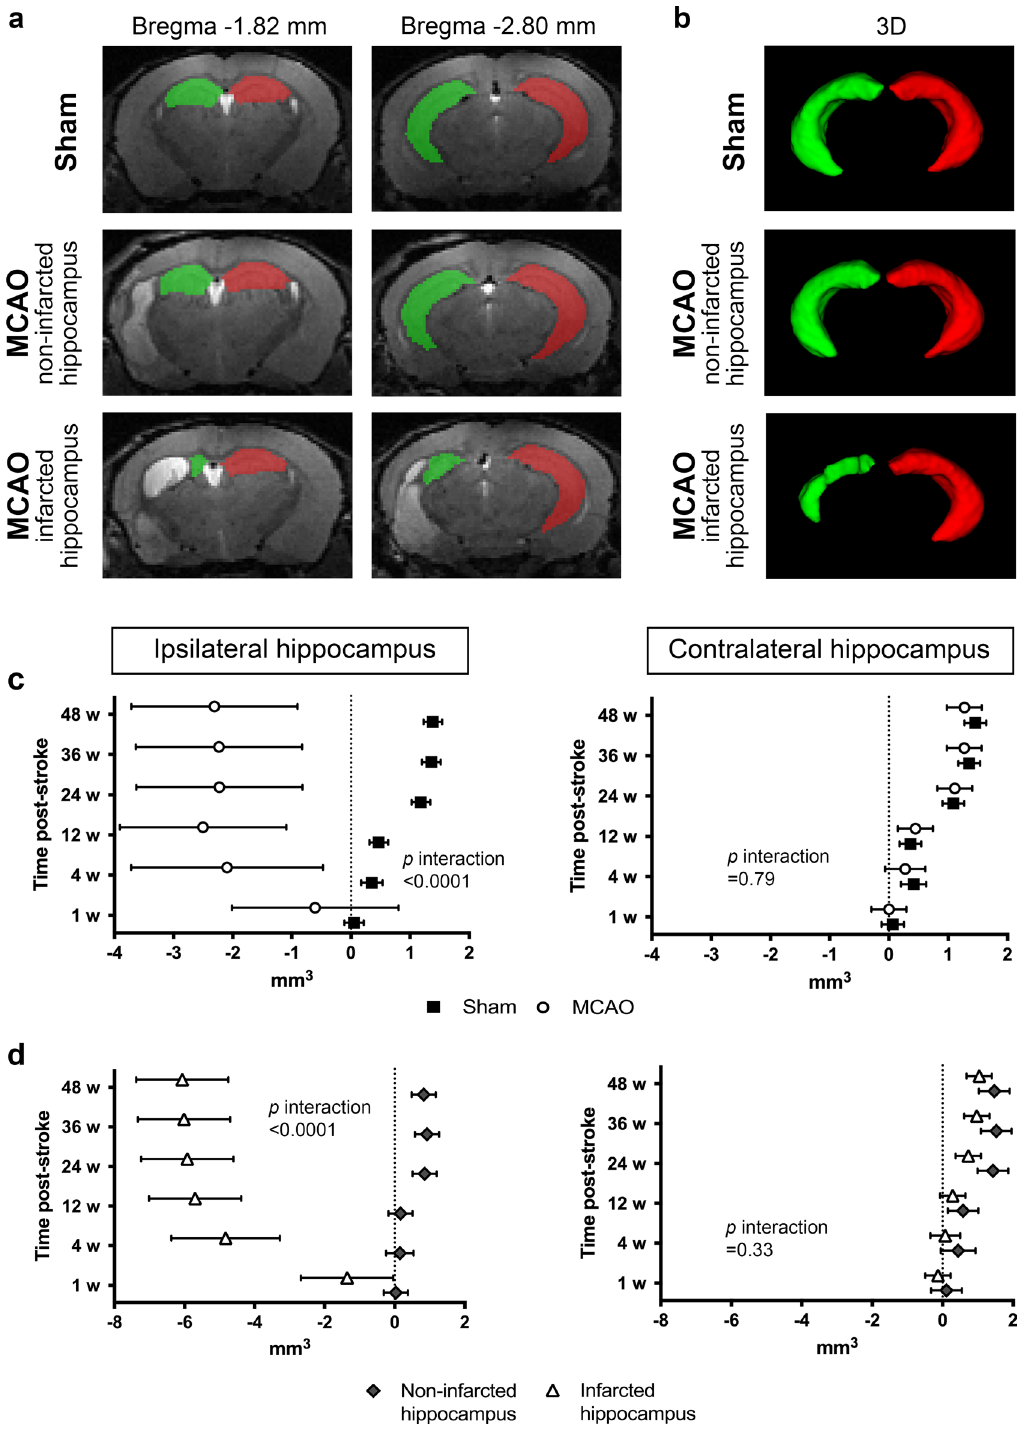
Figure 2. Hippocampal volume. ( a ) Representative T 2 -weighted images of a sham-operated mouse, an MCAO-operated mouse with a non-infarcted hippocampus, and an MCAO-operated mouse with an infarcted hippocampus with manual segmentation of the ipsilateral (green) and contralateral (red) hippocampus at 12-weeks post-surgery. ( b ) Representative 3D images of a sham-operated mouse, and an MCAO-operated mouse with and without an infarcted hippocampus with manual segmentation of the ipsilateral (green) and contralateral (red) hippocampus at 12-weeks post-surgery. ( c ) Volume changes of the ipsilateral and contralateral hippocampus in sham- (black squares) and MCAO-operated mice (white circles) at each time point measured (n = 7–11). ( d ) The MCAO-operated mice were further subdivided into those with and without an infarcted hippocampus. Volume changes of the ipsilateral and contralateral hippocampus in MCAO-operated mice with a non-infarcted hippocampus (gray diamonds) and with an infarcted hippocampus (white triangles) at each time point measured (n = 3–6). Random effect generalized least squares regression test. The effect sizes are presented as mean differences in volume (mm 3 ) between the given time point and baseline with corresponding 95% confidence intervals ( p < 0.05 when the error bars do not touch the dotted line at 0, and the further the deviation from this, the greater the